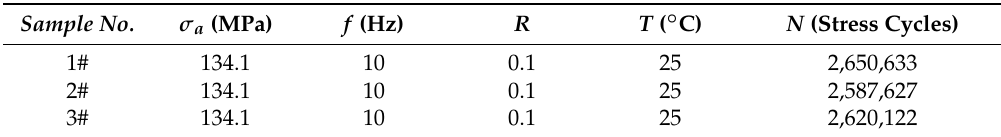
Table 4. Statistical analysis of the fatigue data.